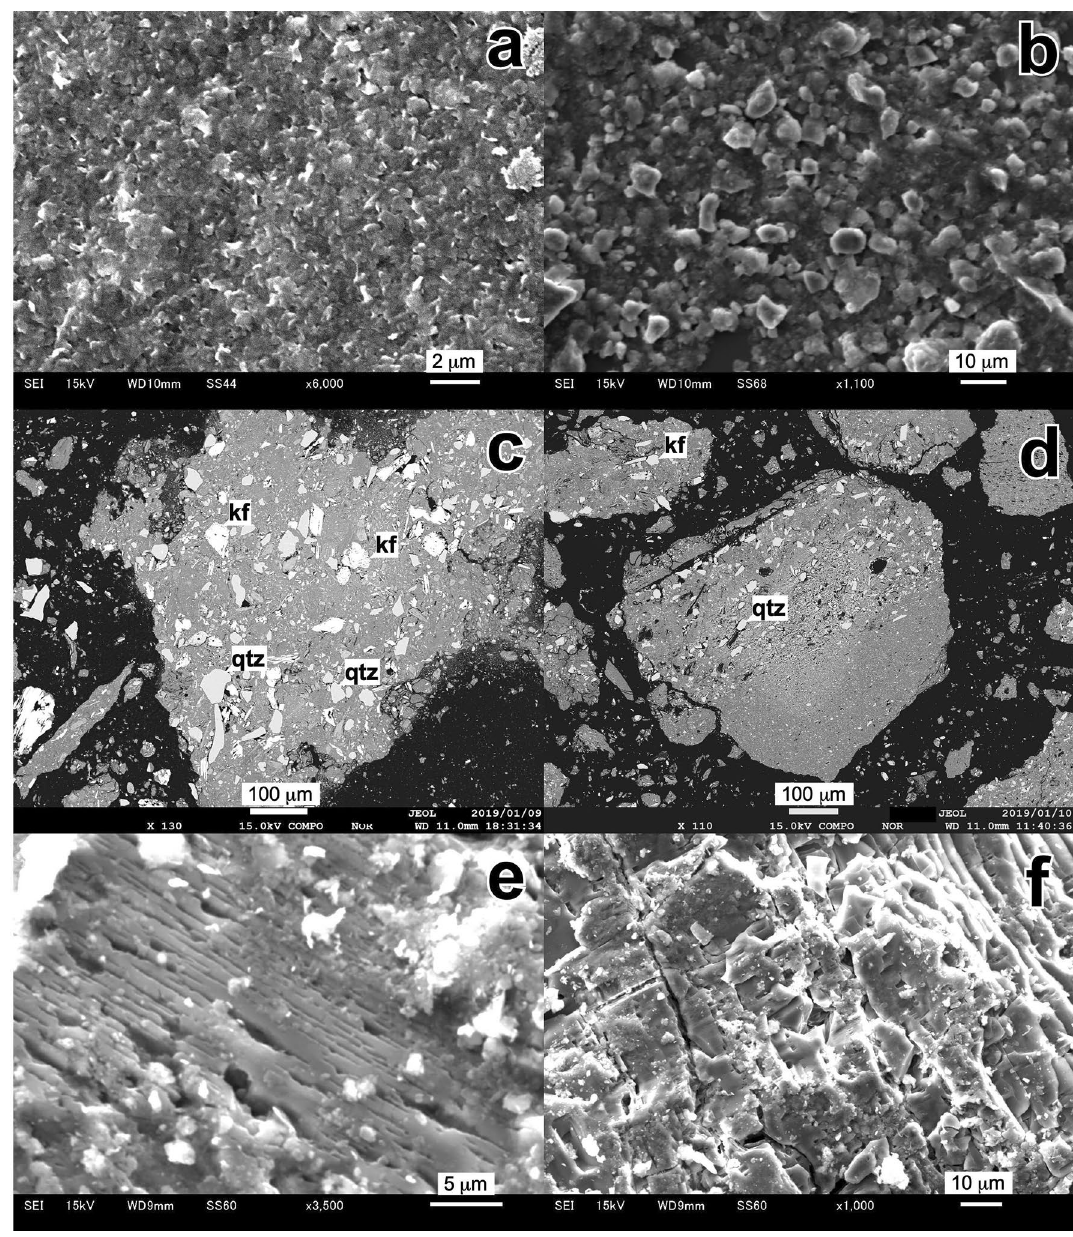
Figure 6. Electron micrographs ( a , b ) are secondary electron images (SEI) of gaerome and kibushi clay, respectively. Electron micrographs ( c , d ) are back scattered electron (BSE) images of polished sections of gaerome and kibushi clay, respectively. The aggregate grains comprise mainly fine-grained kaolinite (gray parts) and fragments of K-feldspar and quartz. Electron micrographs e and f are SEI of K-feldspar in gaerome clay. The decomposed surface of K-feldspar resembles an etched